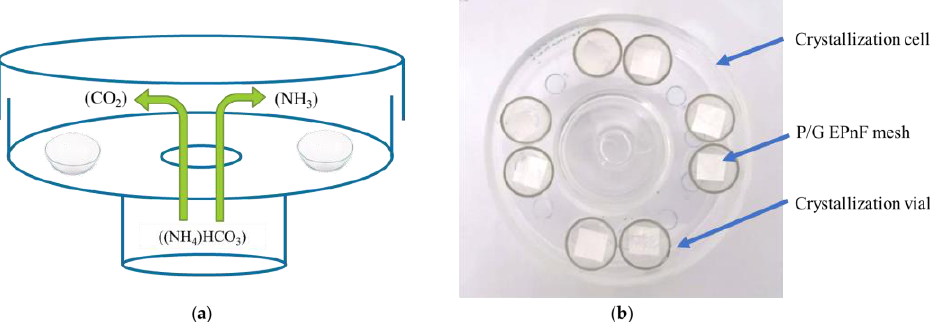
Figure 2. Schematic representation and photograph of the GD crystallization method. ( a ) Schematic of the crystallization cell with crystallization vials inside, and ( b ) photograph (top view) of the crys- tallization cell with vials containing P/G EPnF meshes.